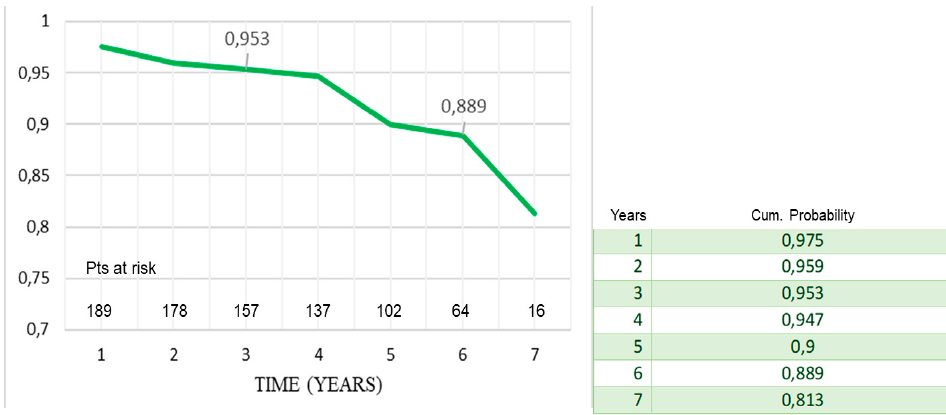
Figure 2. Event-free survival after Bentall operation.